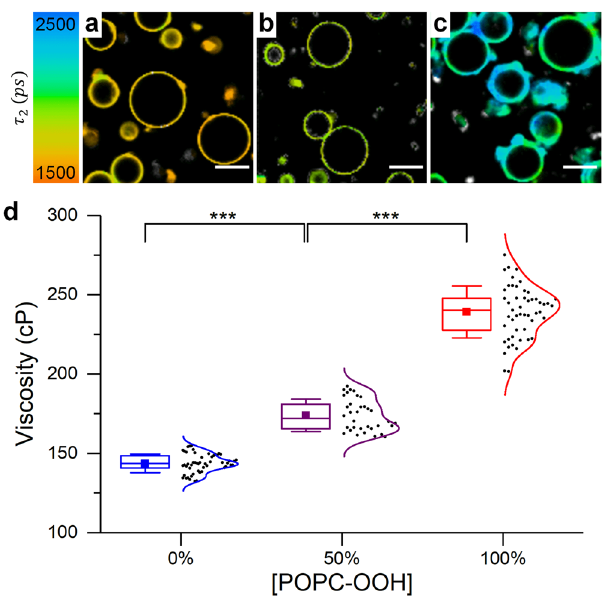
Fig. 5 FLIM imaging of POPC/POPC-OOH GUVs. a – c Sample FLIM images of BC6 + + stained GUVs with increasing fractions of POPC-OOH. Scale bar: 20 µ m. d Calculated membrane microviscosity using the reported rotor calibration 85 . Box plots display the 25 – 75% range, error bars represent ± S.D., median is shown by a horizontal line and mean by a dot of N ≥ 30 GUVs from n = 3 independent